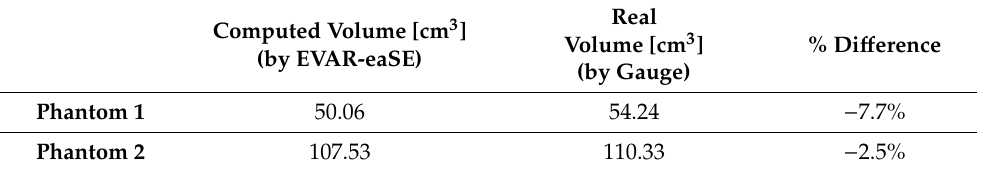
Table 4. Comparative results between mean “computed” volume (by EVAR-eaSE) and “real” volume (by gauge), for both radiological phantoms.